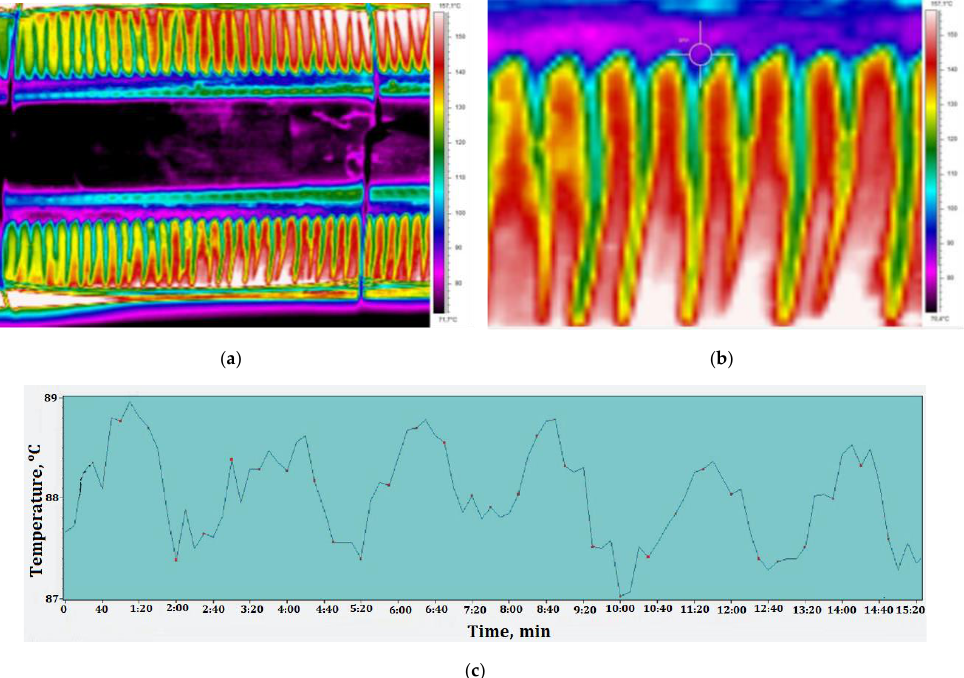
Figure 12. Results of the thermographic examinations of the MAG-welded tube: ( a ) general thermo- gram of heat distribution in the tube, ( b ) detailed thermogram, and ( c ) temperature distribution at point SP02 for a period of up to 15.2 min.